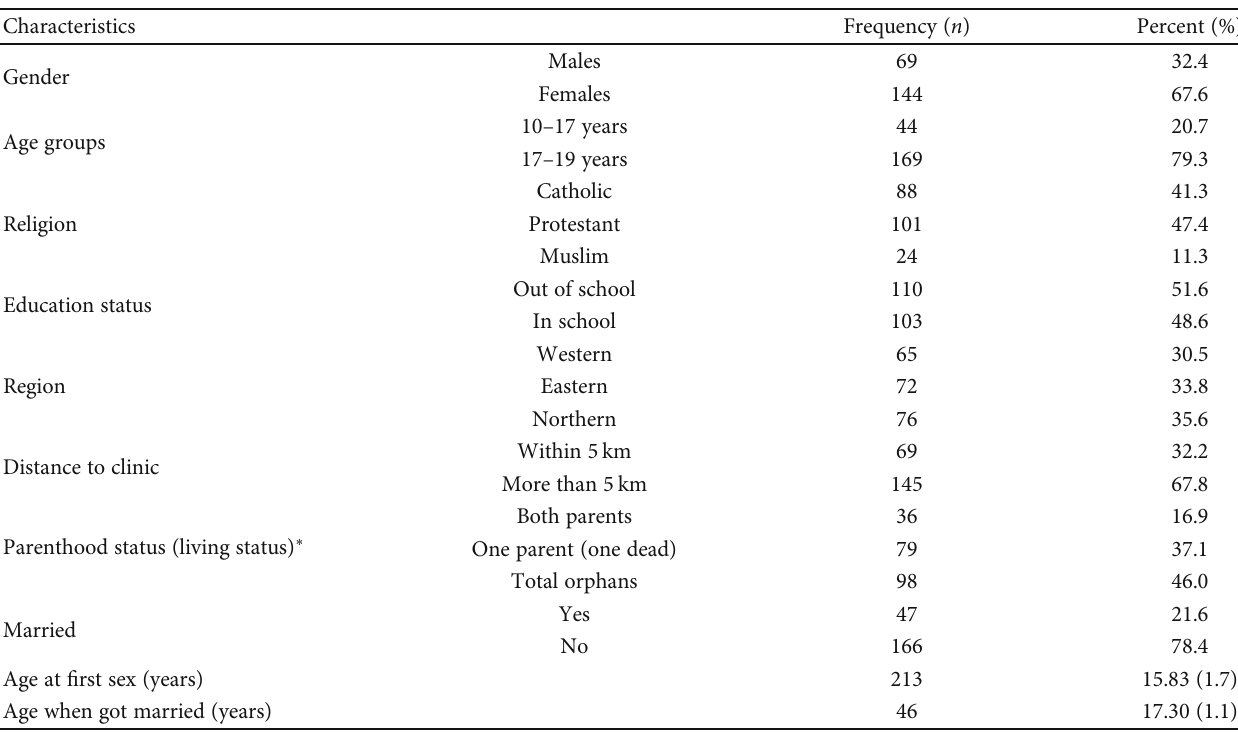
Table 1: Distribution of sociodemographic characteristics of 213 HIV perinatally infected adolescent in Uganda.